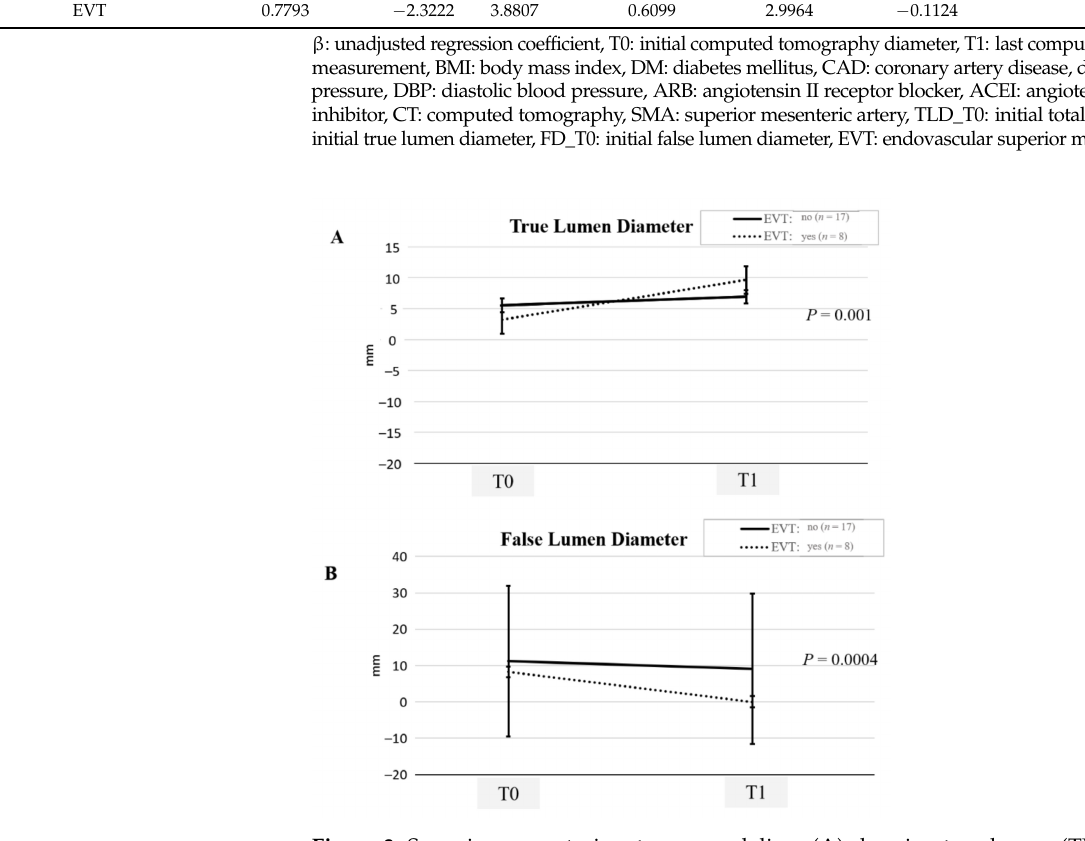
Figure 3. Superior mesenteric artery remodeling. ( A ) showing true lumen (TL) expansion and ( B